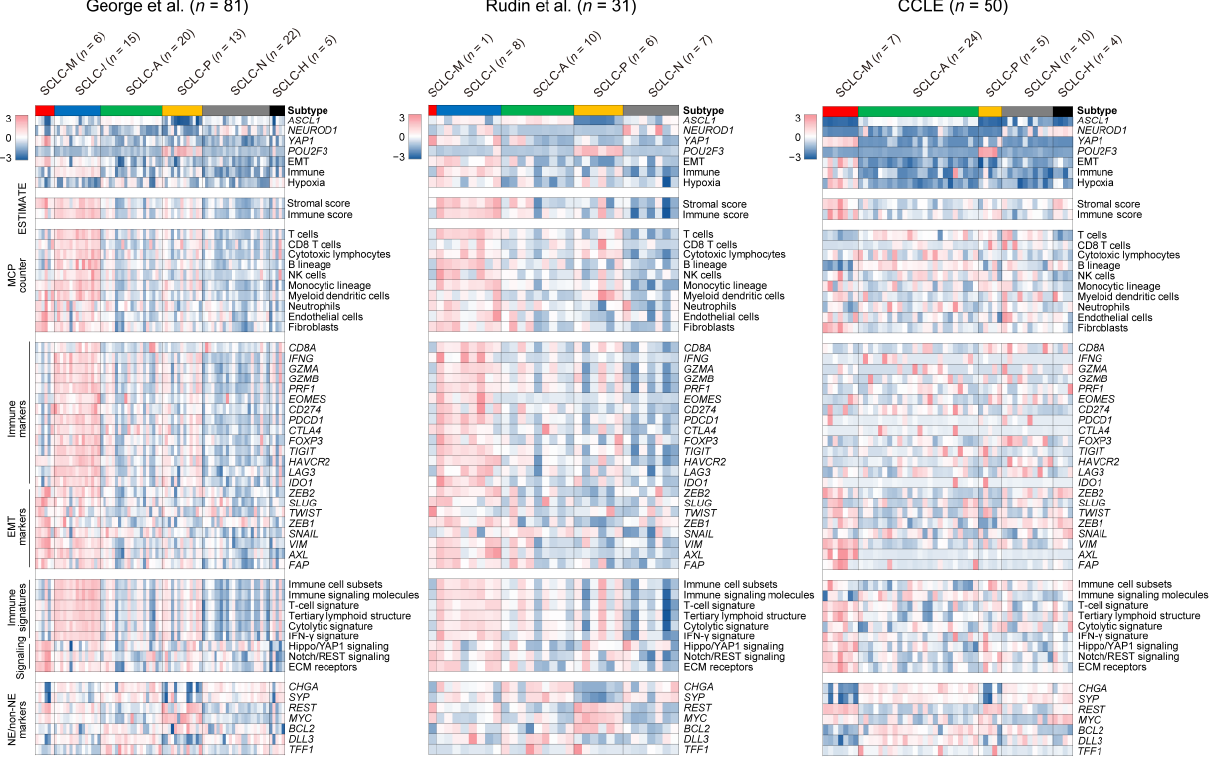
Figure 2. Molecular features of SCLC subtypes. Various molecular and cellular features of the six SCLC subtypes are shown as heatmaps. Along with the primary dataset used for subtype discovery (George et al., left ), results for two additional cohorts (Rudin et al. ( middle ) and CCLE ( right )) are presented. Levels of the four transcriptional regulators and three molecular functions indicated in Figure 1D are shown. Stromal-immune scores (‘ESTIMATE’) and the abundance of 10 immune and stromal cell types (‘MCPcounter’) are also shown. Relative immune activities are shown for 14 immune genes (‘Immune markers’) and six immune pathways (‘Immune